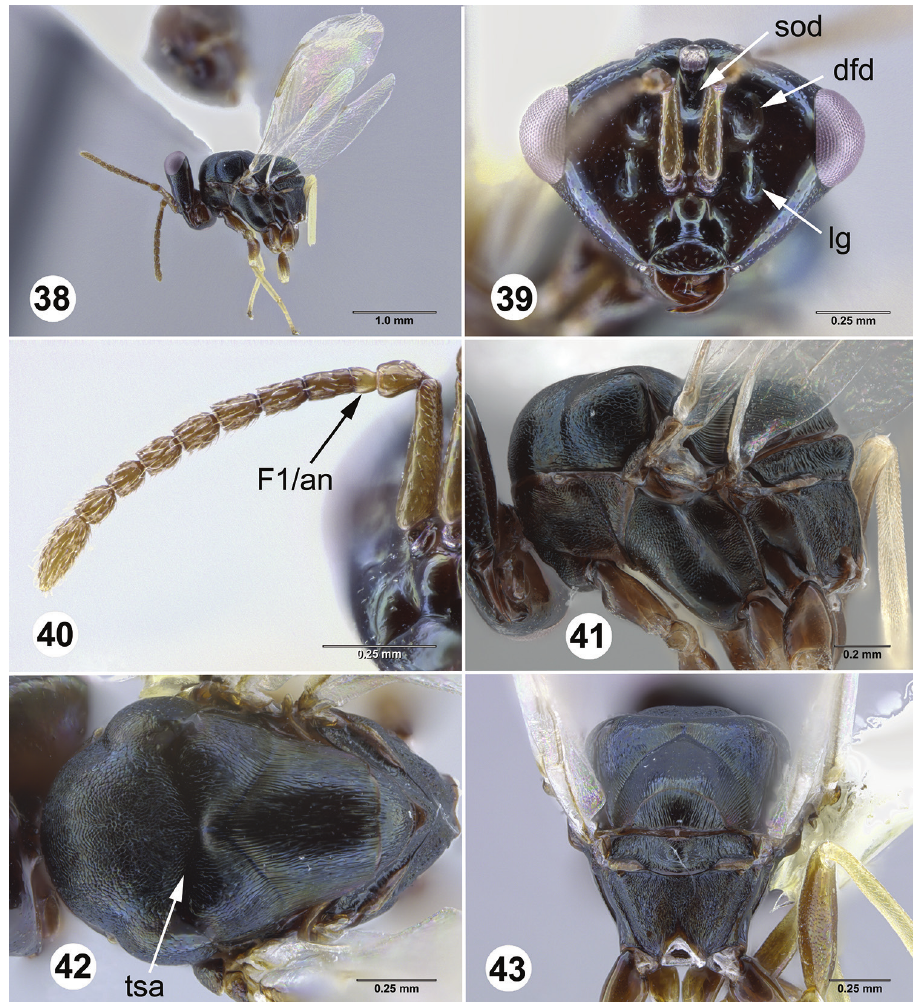
Figures 38–43. Ivieosema confluens . Paratype female : 38 head and mesosoma, lateral 39 head, anterior 40 antenna, medial 41 mesosoma, lateral 42 mesosoma, dorsal 43 mesosoma, posterior. dfd = dorsal frontal depression; F1/an = anellus; lg = longitudinal groove; sod = subocellar depression; tsa = transscutal